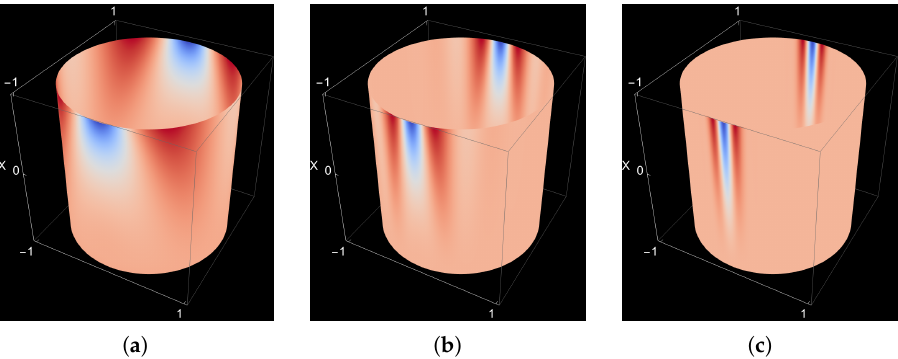
Figure 4. Parabolic case: transverse deflection profiles. ( a ) t = 10 − 2 . Range w ∈ [ − 0.188302,0.074928 ] . ( b ) t = 10 − 4 . Range w ∈ [ − 1.98151,0.988704 ] . ( c ) t = 10 − 6 . Range w ∈ [ − 3.10864,1.47145 ] .